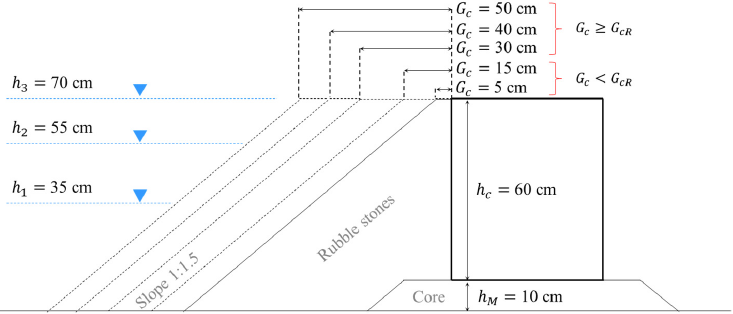
Figure 6. Illustration of the experimental setup with different values of the shoulder width of the rubble mound ( 𝐺 (cid:3030) ) and water depth ( ℎ